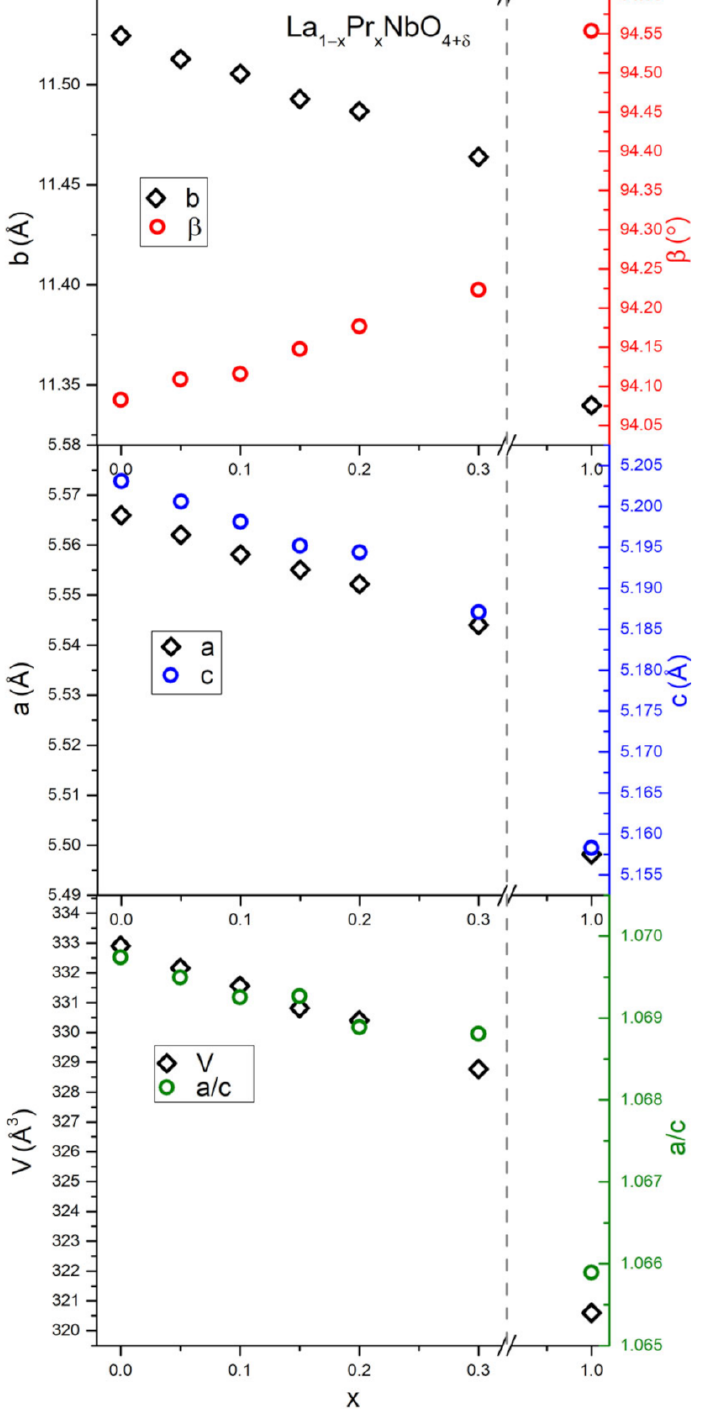
Figure 2. The unit cell parameters and deviation from tetragonality (a/c) of La 1 − x Pr x NbO 4+ δ as a function of praseodymium